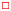
Effect of time, temperature and pH on coupling of polyP to amine-PEG2-biotin.A) PolyPnarrow was reacted with EDAC and amine-PEG2-biotin at unbuffered pH 8 at 37°C for 1 h or overnight, or at 60°C for 1 h, then resolved by PAGE. The fidelity of the size distribution was preserved in the 37°C 1 h reaction, but serious degradation was observed in the other reaction conditions. B) To determine the optimal reaction pH, polyP1000 was reacted with amine-PEG2-biotin and EDAC for 1 h at 37°C at a variety of unbuffered pH solutions. After purification, each was evaluated by thrombin-binding assay and the results were normalized to the highest value obtained. C) To determine if the inclusion of buffers inhibited the EDAC-mediated coupling reactions, polyP1000 was reacted with amine-PEG2-biotin and EDAC for 1 h at 37°C in a reaction mixture that included pH 8.0 MOBS-NaOH (□) or pH 8.0 MOPS-NaOH (▲) buffers, or by adjusting the pH of the unbuffered solution to 8.0 with HCl (○). After purification, the coupling efficiency of each preparation was evaluated by thrombin-binding assay, with the results normalized to the highest value obtained.